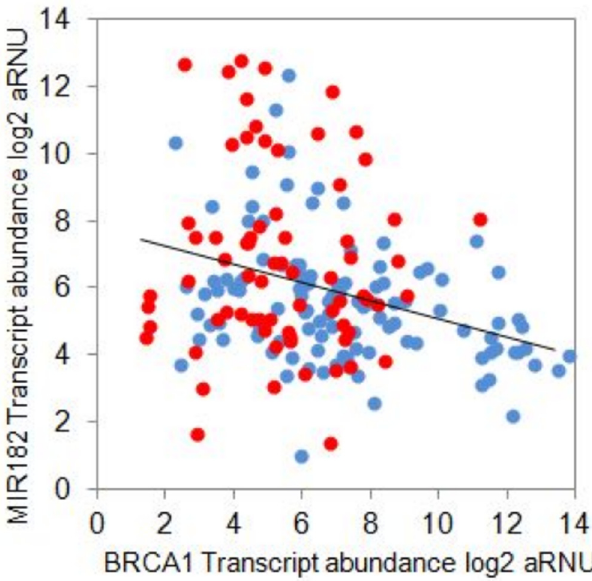
Fig 5. Scatter plot of expression of MIR182 v BRCA1:MIR182. Scatter plot of expression of MIR182 v BRCA1:MIR182 expression correlated to being highest in TNBC class (Pearson ’ s CC- − 0.27, * p < 0.05) There is also an inverse correlation between MIR182 and